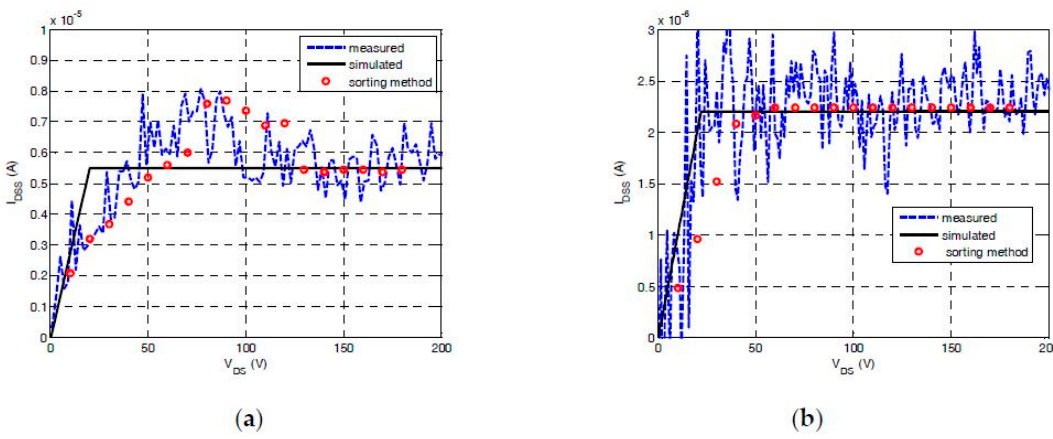
Figure 12. Leakage current ( I DSS ) versus drain-to-source voltage ( V DS ) in the ( a ) fabricated GaN FET and ( b ) commercial GaN FETs [TPH3006PS].